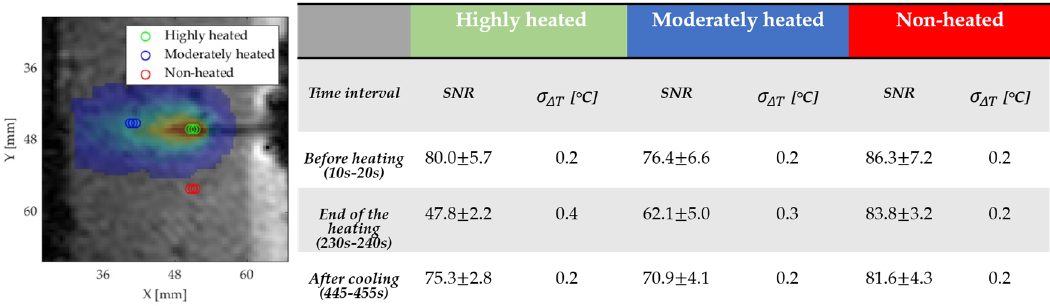
Figure 6. SNR and uncertainty (cid:2026) (cid:2940)(cid:3021) results for the three ROIs shown in the figure on the in the three- time intervals (see Figure 7). intervals (see Figure 7).